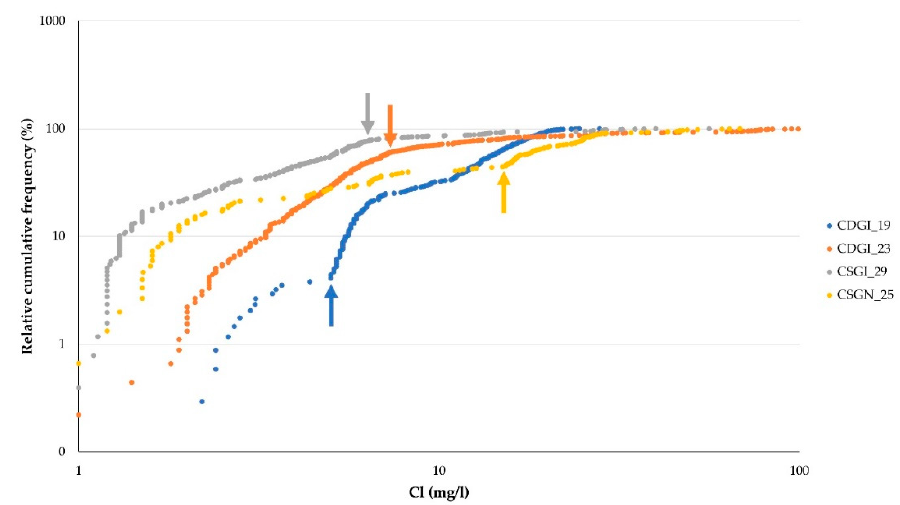
Figure 11. Cumulative relative frequencies of chloride (Cl) for analysed groundwater bodies. Arrow indicates value x considered for the calculation of Mean + 2SD and Median + 2MAD ranges for each groundwater body.